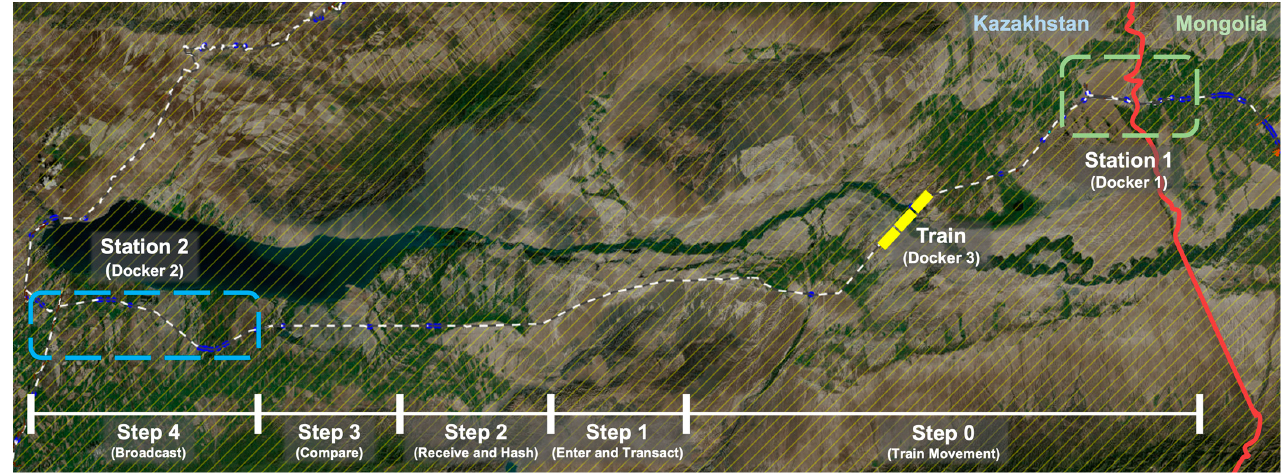
Figure 10. Simulation of NSCC from Mongolia to Kazakhstan using SUMO.